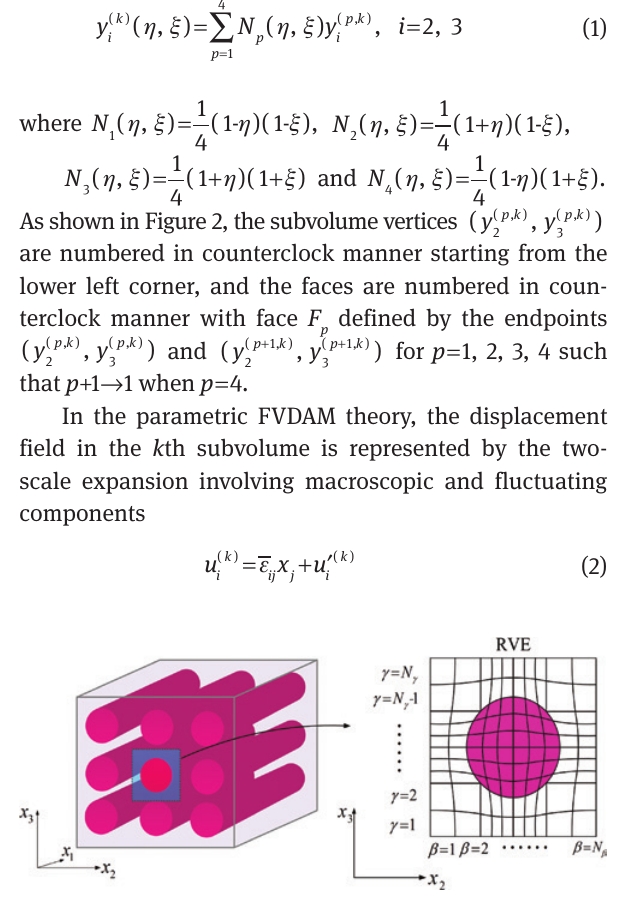
Figure 1: A composite laminate with periodic microstructure and its